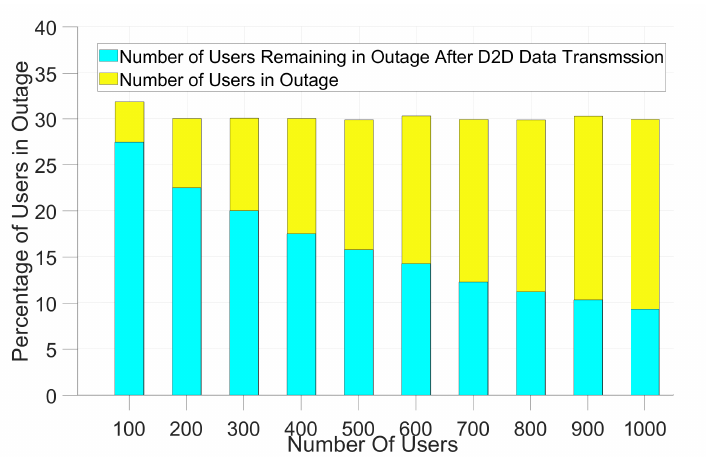
Figure 4. Device-to-Device communications to reduce the number of outage users.